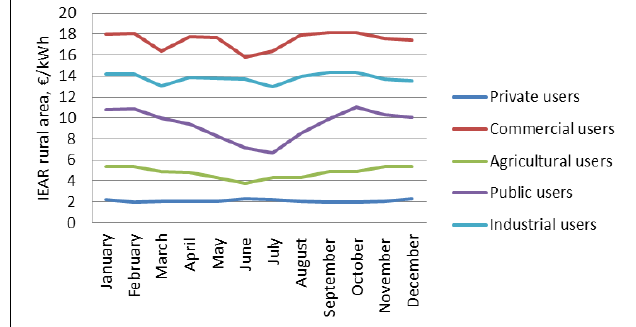
Fig. 6. IEAR in a urban area.